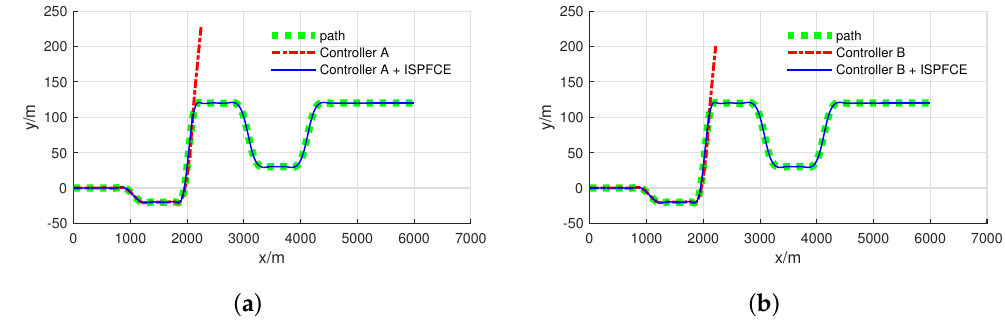
Figure 22. Lane-keeping performance of vehicles controlled by different controllers: ( a ) Controller A and ( b ) Controller B.